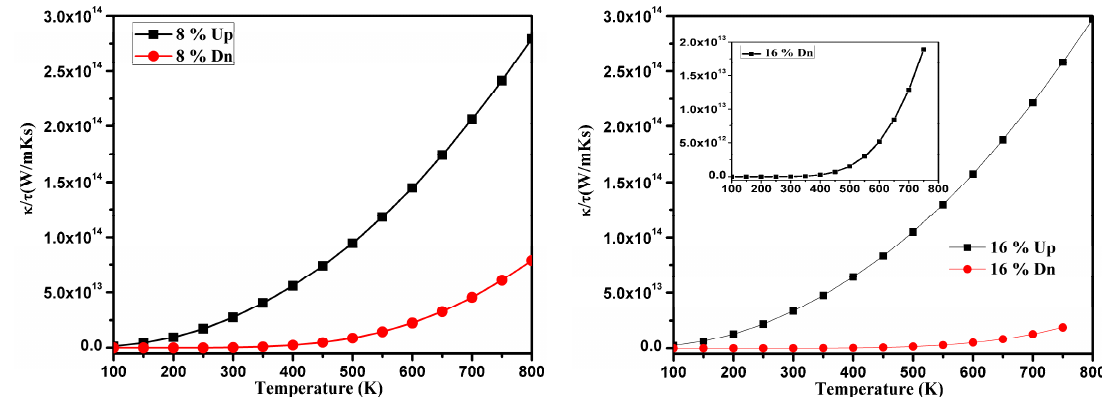
Figure 13. Thermal conductivity (long solid curve ‐ black color for up) and (long solid curve ‐ red color for down) dependences versus temperature for Mn x Zn 1 − x Te (x = 8% and 16 %).